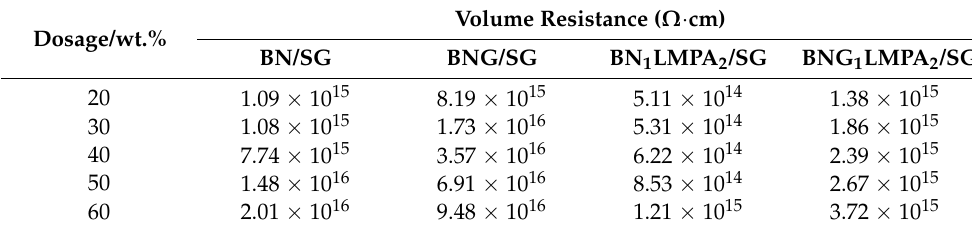
Table 2. Volume resistivity of different TCG.